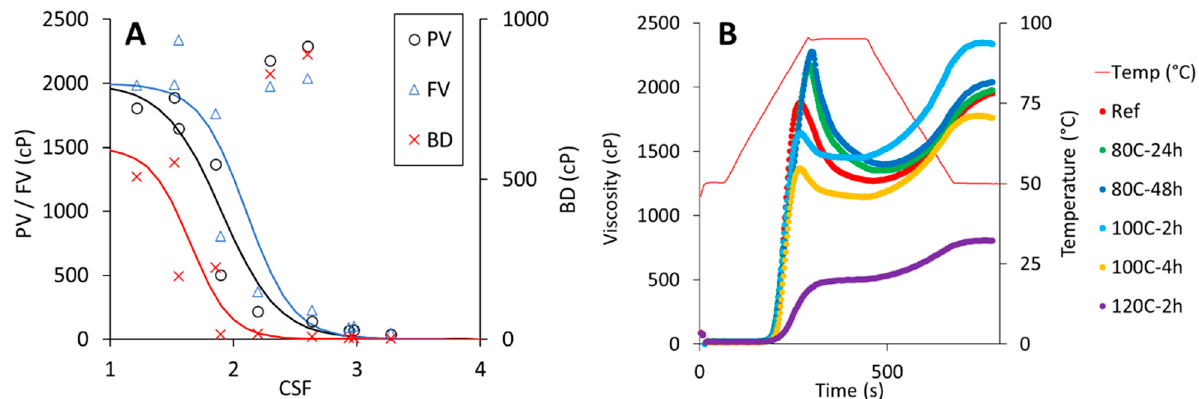
Figure 5. Pasting properties (i.e., PV = peak viscosity, FV = final viscosity and BD = breakdown) as a function of the combined severity factor CSF ( A ). Pasting profiles of native (Ref) and dry-heated CPF that were selected for the breadmaking experiments ( B ). For the dry-heated CPF samples, the temperature (C) and time (h) treatment conditions are indicated by the codes.